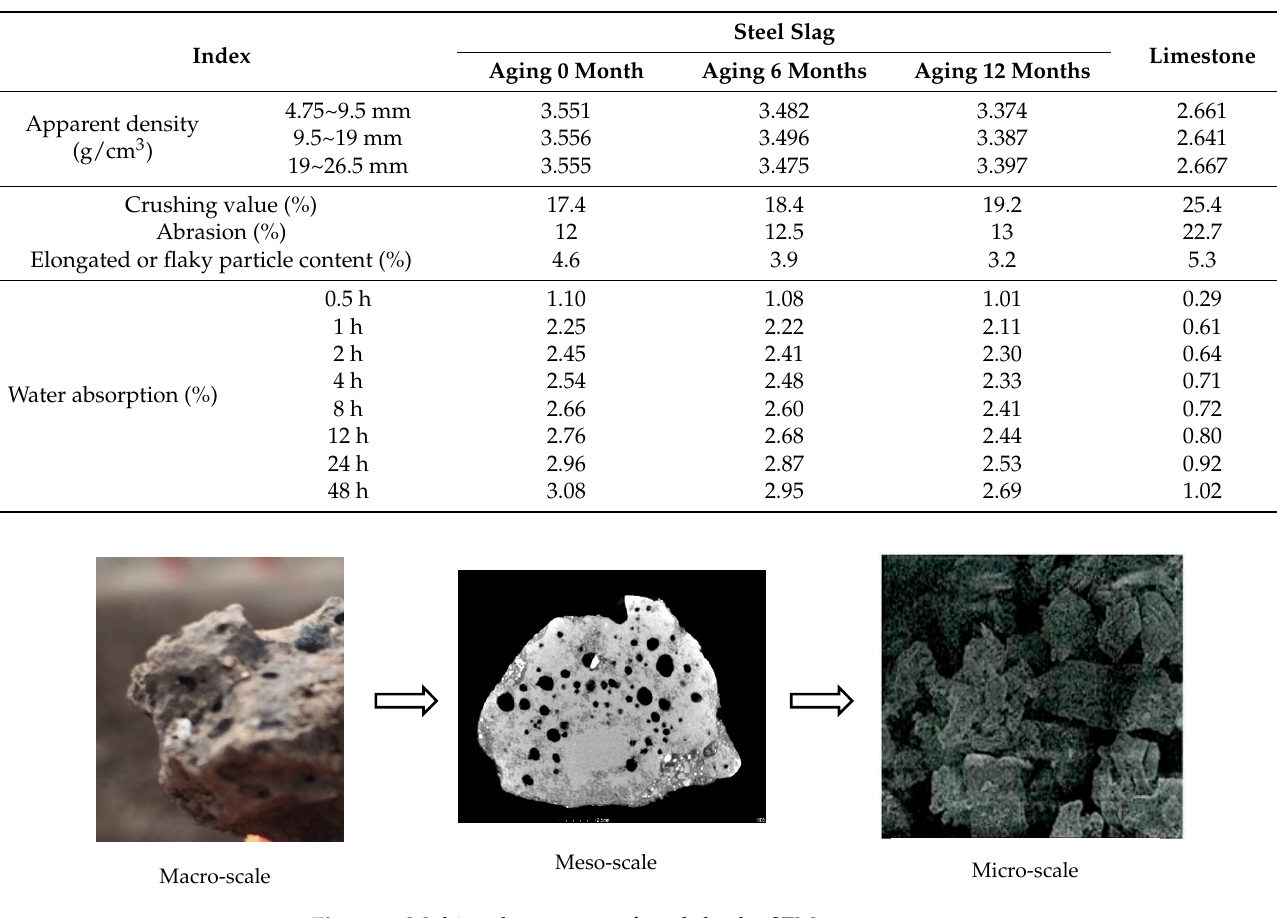
Figure 2. Multi-scale structure of steel slag by SEM. Table 2. Chemical composition of steel slag (%).